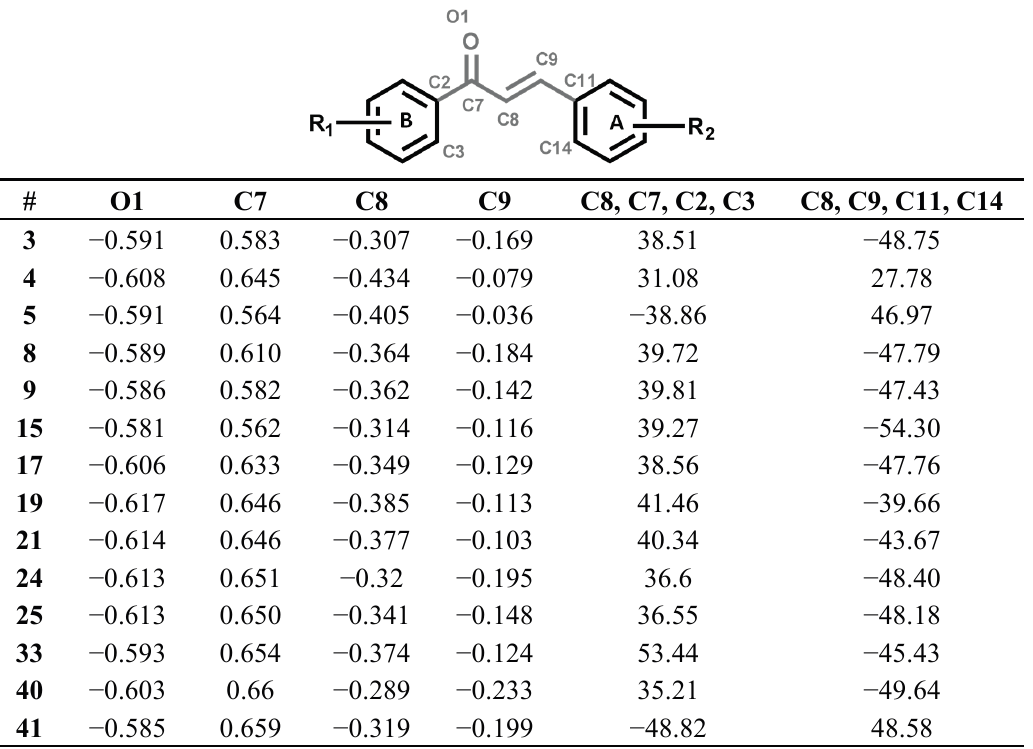
Table 4. α , β -Unsaturated carbonyl chalcones derivatives (O1, C7, C8 and C9) electrostatic charging system distribution and variation in dihedral angles according to the substituent change on aromatic